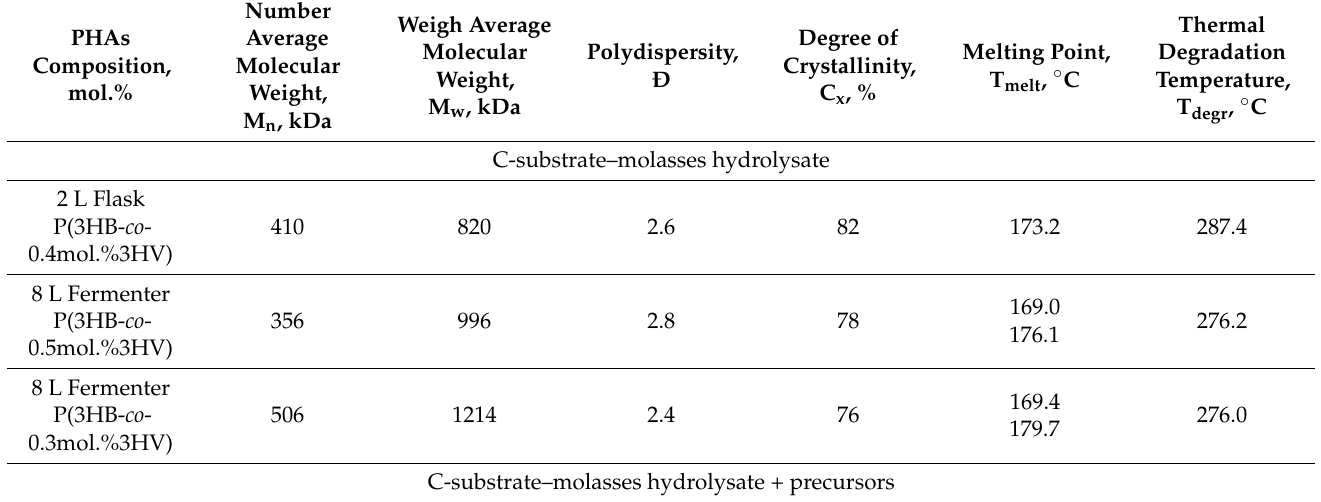
Table 3. Properties of PHAs synthesized Cupriavidus necator B-10646 from sugar beet molasses